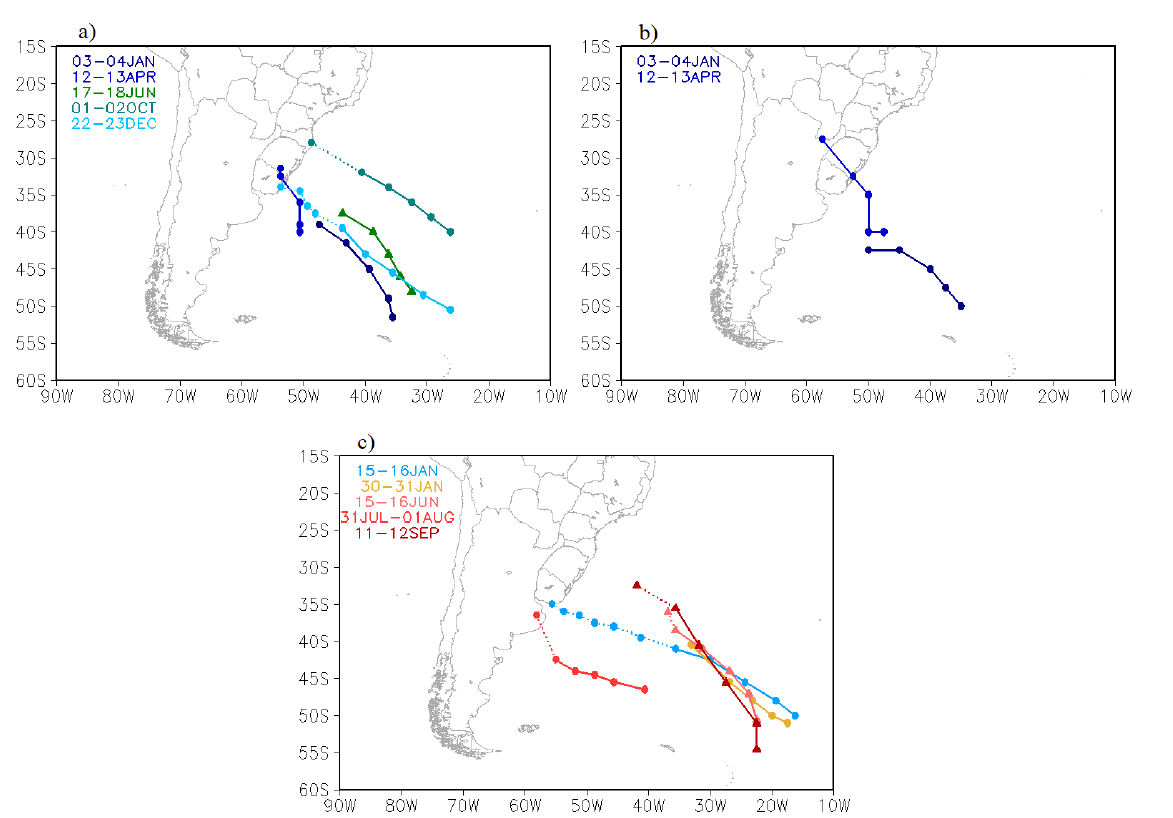
Figure 3. Trajectories of intense explosive cyclones (dashed lines – non-explosive phase; solid lines – explosive phase): a) MERRA-2 in 2014; b) NCEP2 in 2014; c) MERRA-2 in 2015. Systems with solid circle trajectories are common cases of the two reanalyses, while those with solid triangle trajectories are cases only of the presented reanalysis.